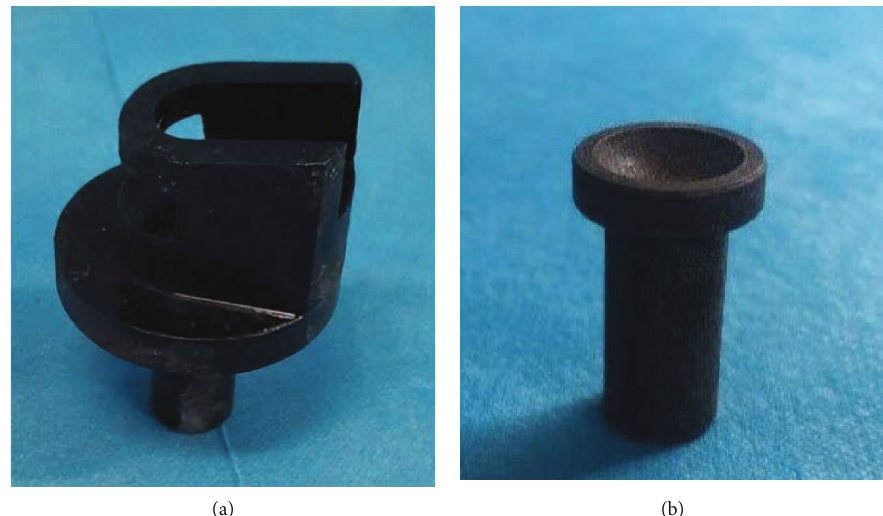
Figure 3: Fixed cups of rat tibia in the custom-made dynamic loading device: (a) the bottom cup and (b) the top